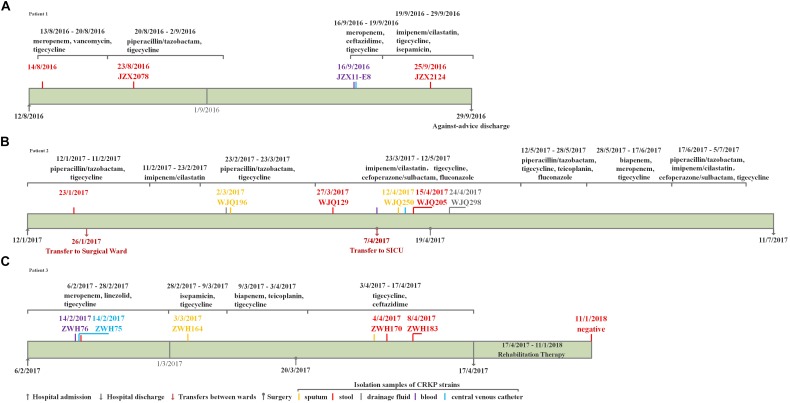
The clinical course, therapeutic regimen, and outcomes of Patient 1 (A), Patient 2 (B) and Patient 3 (C) who carried CRKP isolates.